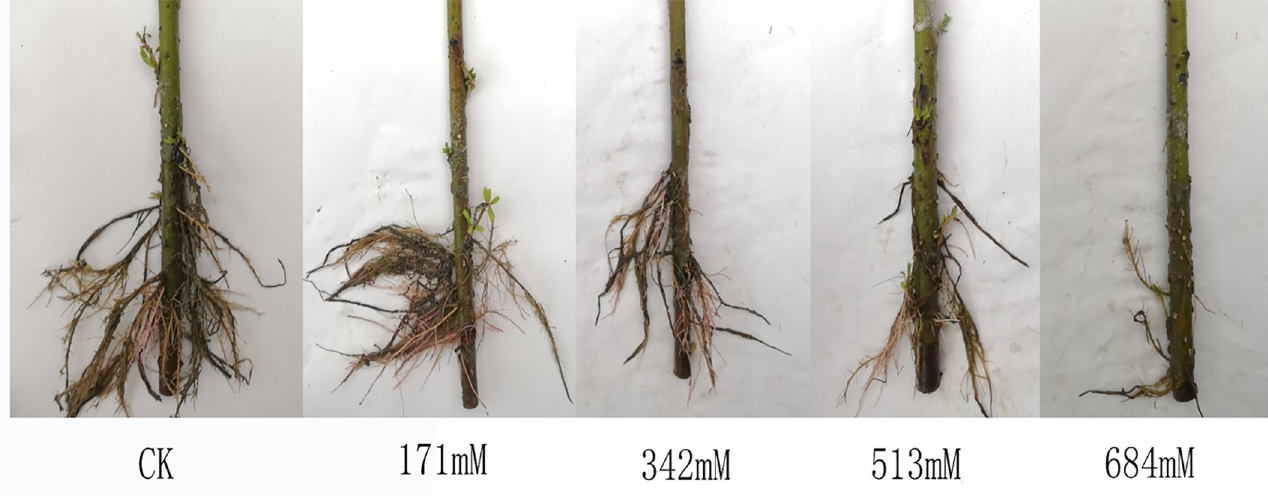
Fig 2. Changes of root growth of Salix alba L. under salt